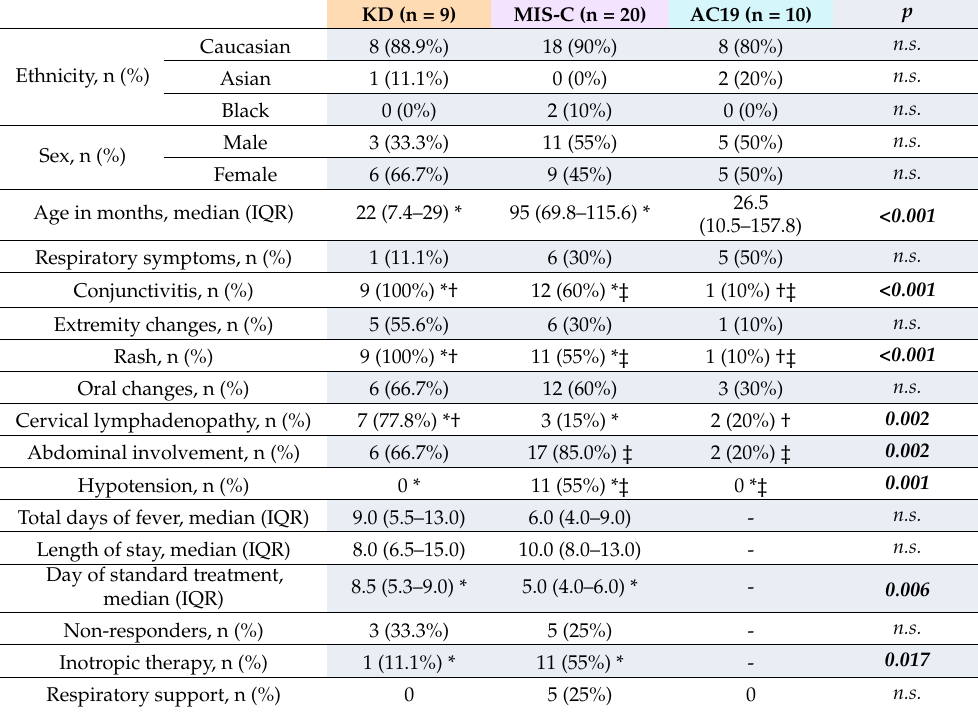
Table 1. Demographic and clinical data of the three groups of patients: KD, MIS-C and AC19.